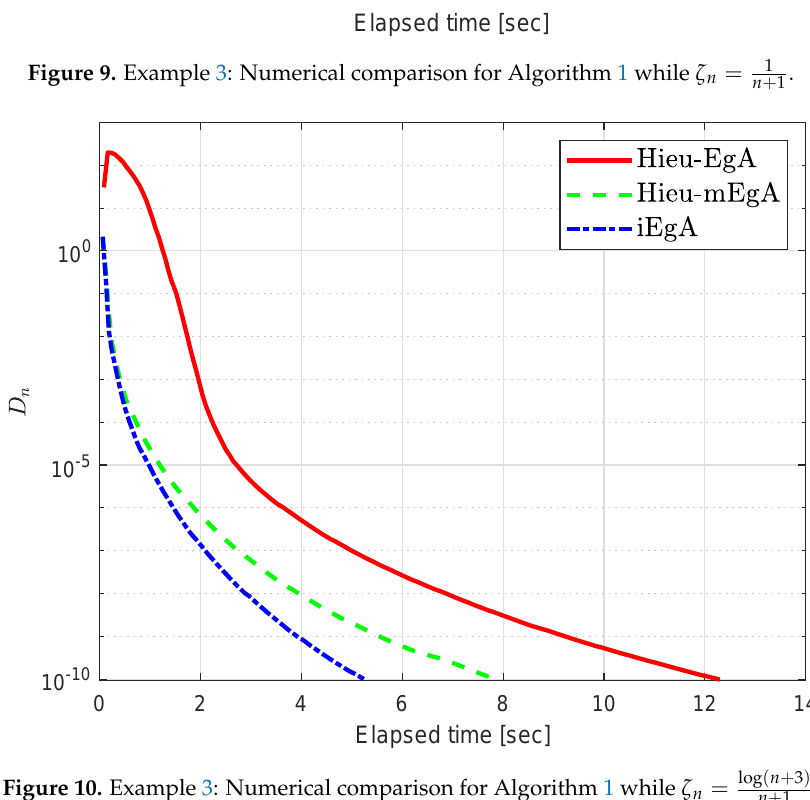
Figure 10. Example 3: Numerical comparison for Algorithm 1 while ζ n = log